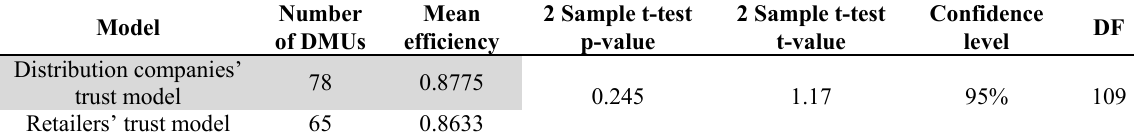
The result of 2 sample t-test between the mean efficiency of both parties for trust tendency Number Model of DMUs Distribution